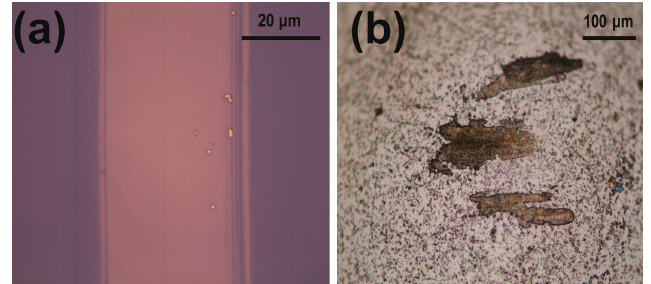
Figure 7. Optical images of the wear track on ( a ) the 2L-MoS 2 -coated flat sample and ( b ) SiC ball after 50 cycles of sliding. 50 cycles of